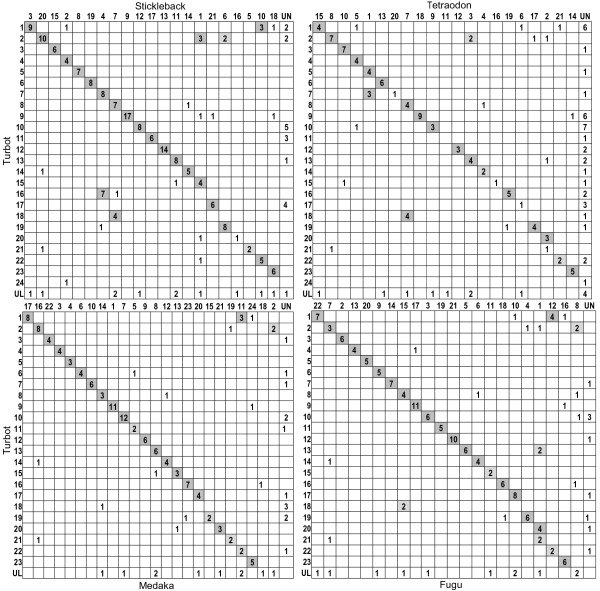
Macrosynteny analysis between the turbot linkage map and model Acanthopterygii genomes. In gray background syntenies with two or more significant hits. UL: unlinked markers in the turbot map; UN: unrandom genomic regions of the model fish species.